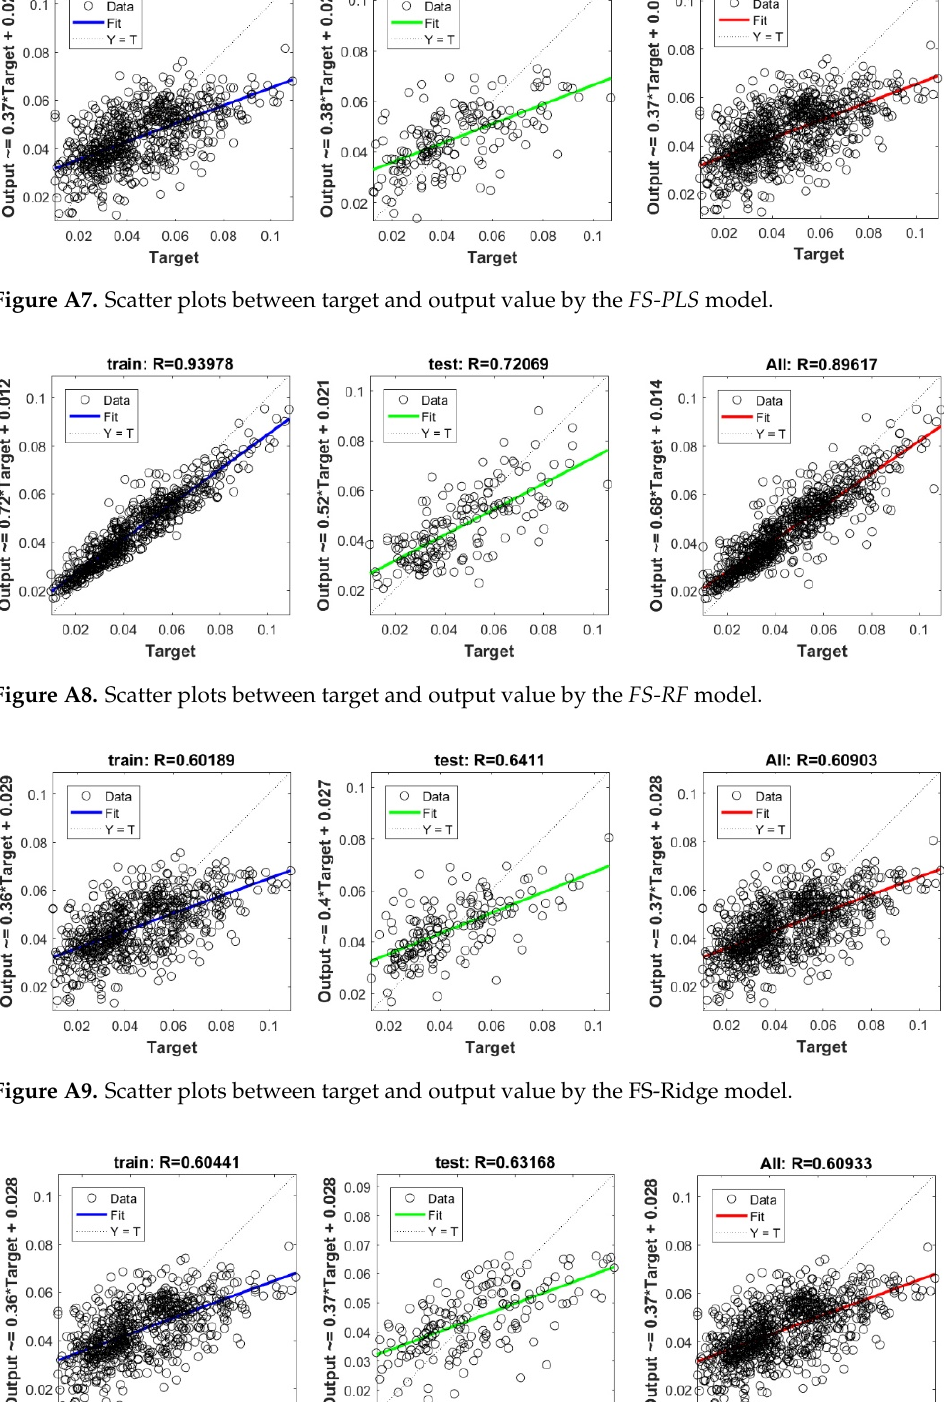
Figure A10. Scatter plots between target and output value by the FS-STEP